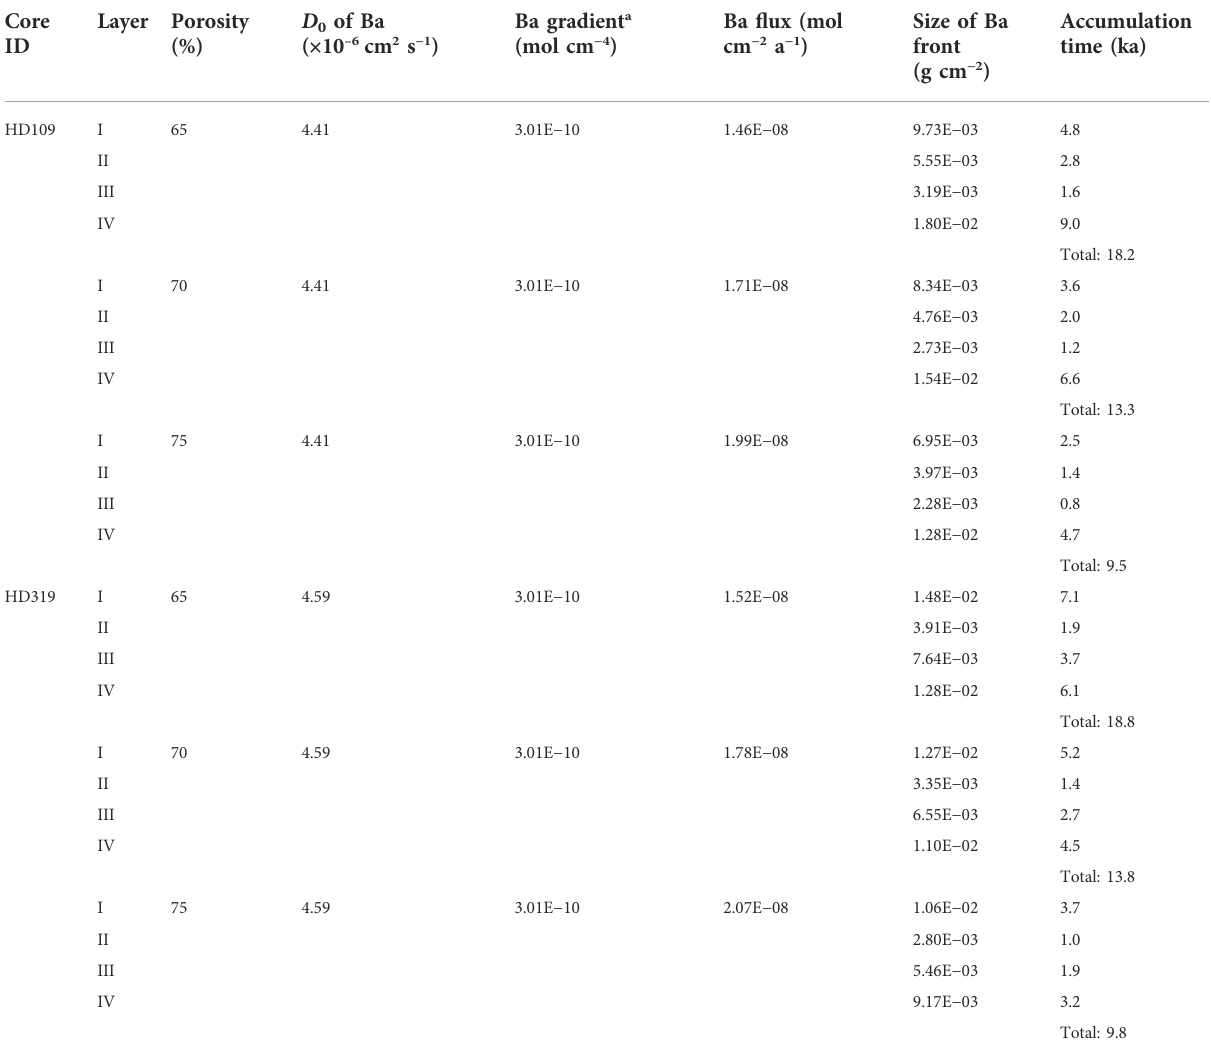
TABLE 8 Calculation of accumulation time of Ba fronts at cores HD109 and